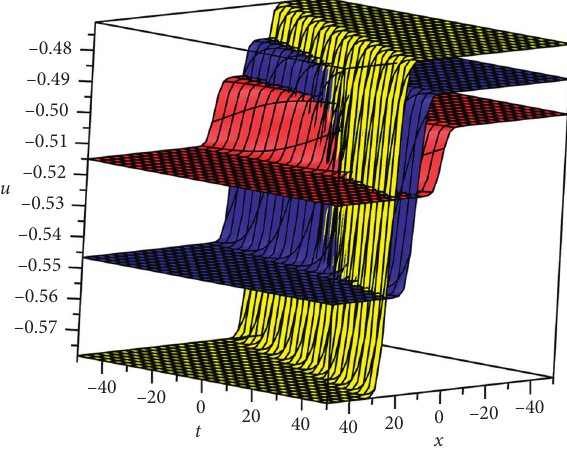
� √ , μ � 0 . 3 ,v � 0 . 1 , and C 2